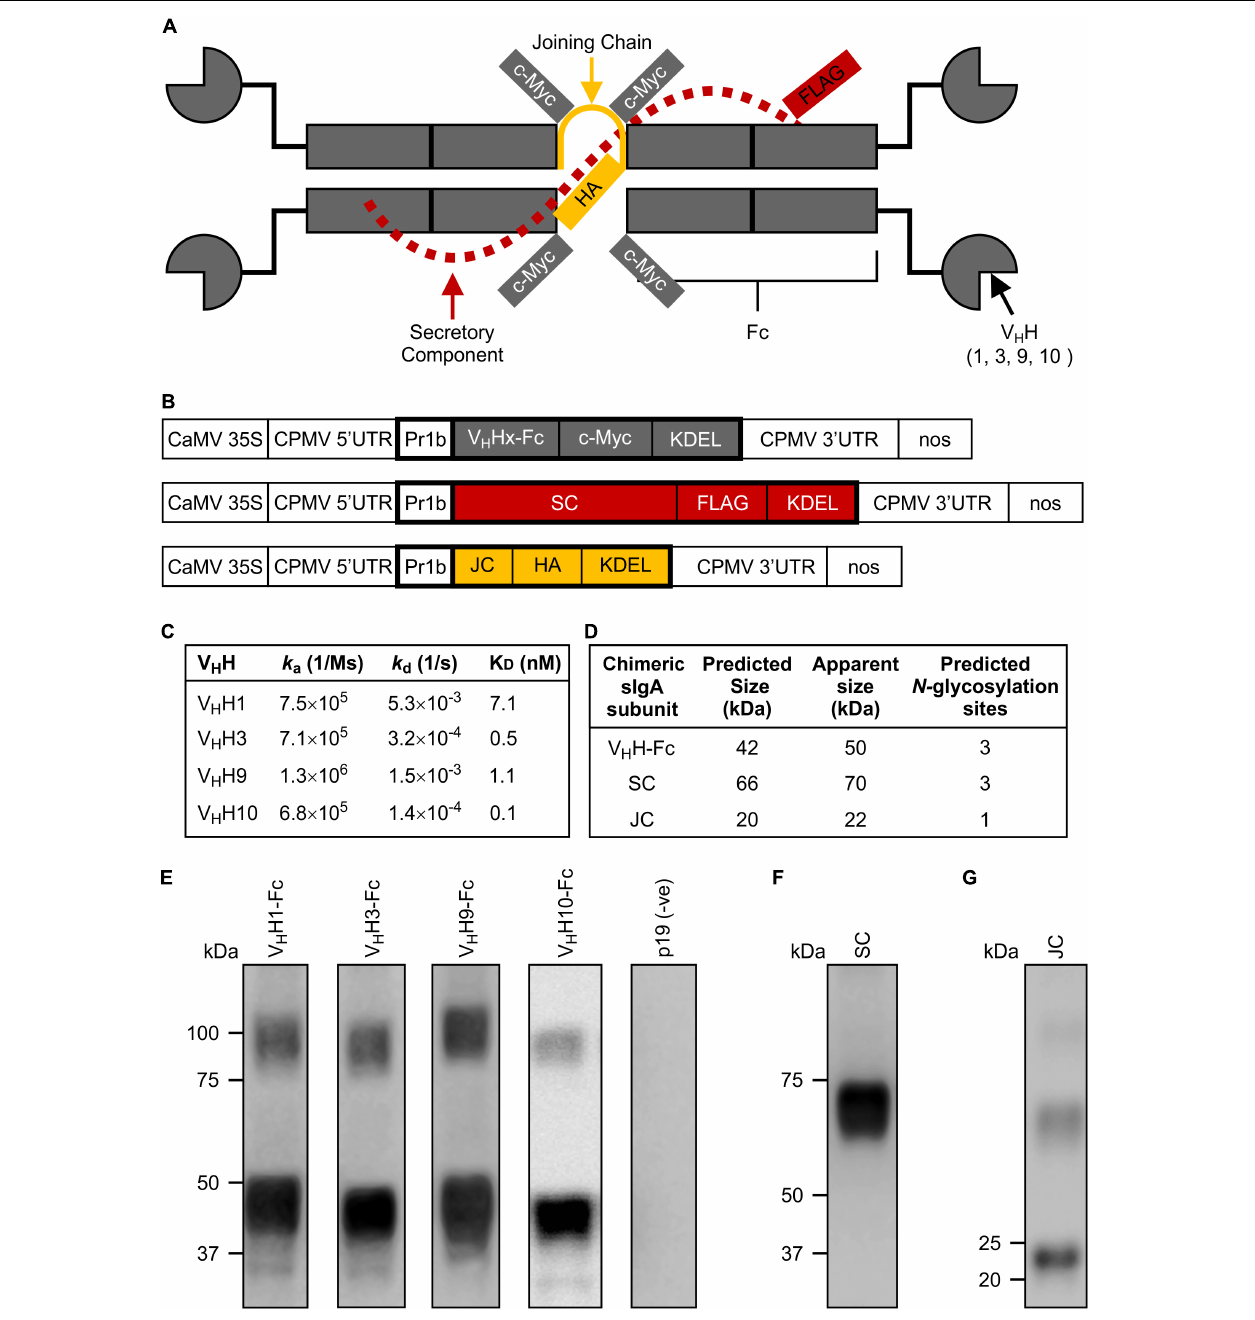
FIGURE 1 | Design and production of individual subunits required for chimeric secretory IgA assembly. (A) Schematic of all produced subunits fully assembled into a chimeric antibody intended for secretory IgA functionality. It notably differs from the structure of native secretory IgA by the replacement of the Fab region with a camelid-derived variable heavy chain fragment (V H H). (B) Schematic representation of constructs used for Agrobacterium -mediated transient expression in N. benthamiana leaves. CaMV 35S, cauliflower mosaic virus 35S promoter; CPMV 5 (cid:48) UTR, 5 (cid:48) -untranslated region of Cowpea mosaic virus; PR1b, tobacco pathogenesis-related protein 1b signal peptide; V H Hx-Fc, fusion of a camelid-derived V H H to a bovine Fc where x is either 1, 3, 9, or 10, corresponding to the isolated V H Hs; SC, bovine secretory component; JC, bovine JC; c-Myc, FLAG, HA, detection tags; KDEL, endoplasmic reticulum retrieval tetra-peptide; CPMV 3 (cid:48) UTR, 3 (cid:48) -untranslated region of Cowpea mosaic virus; nos, nopaline synthase terminator sequence; the cassettes were cloned into pEAQ-DEST-1 plant expression vectors. Schematic not drawn to scale. Bold outlines indicate translated regions. (C) Monovalent affinities and kinetics of the interaction between V H Hs and MBP-Int277 by SPR (pH 7.4, 25 ◦ C). (D) Predicted protein size and number of glycosylation sites for each subunit. (E–G) Western blots of crude extract from leaves of N. benthamiana harvested at 6 dpi expressing V H H1, 3, 9, and 10-Fc along with p19, a suppressor of gene silencing (E) , SC (F) , and JC (G) . 10 µ g of TSP was loaded in each lane.